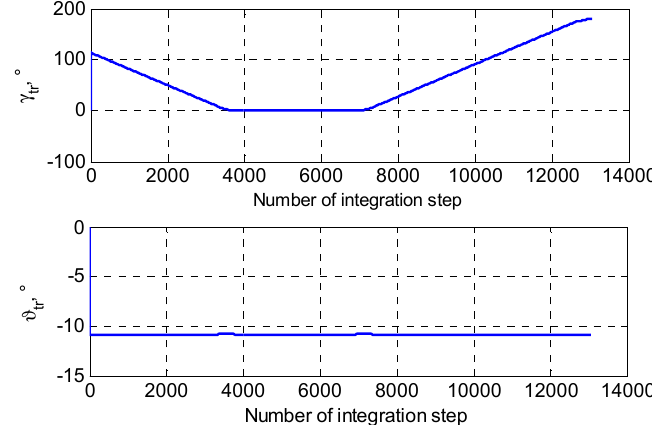
γ tr and dip angle